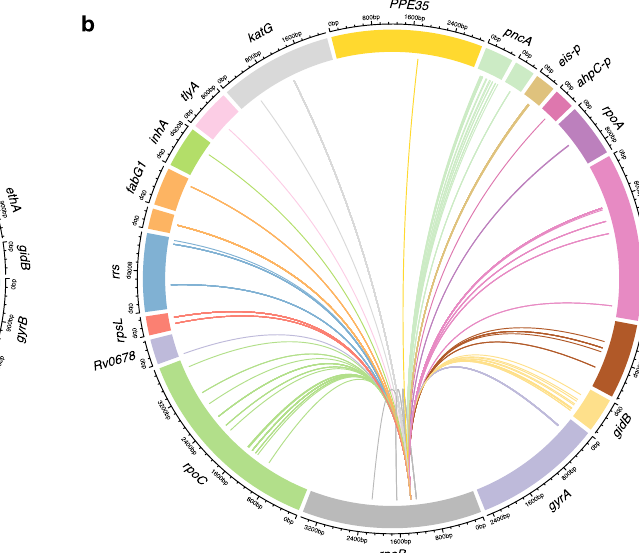
( b ) background. In L2, RpoB S450L interacted with 206 different other resistance- conferring mutations (based on the analysis of 767 genomes). In L4, RpoB S450L interacted with 79 different other resistance-conferring mutations (based on the analysis of 70